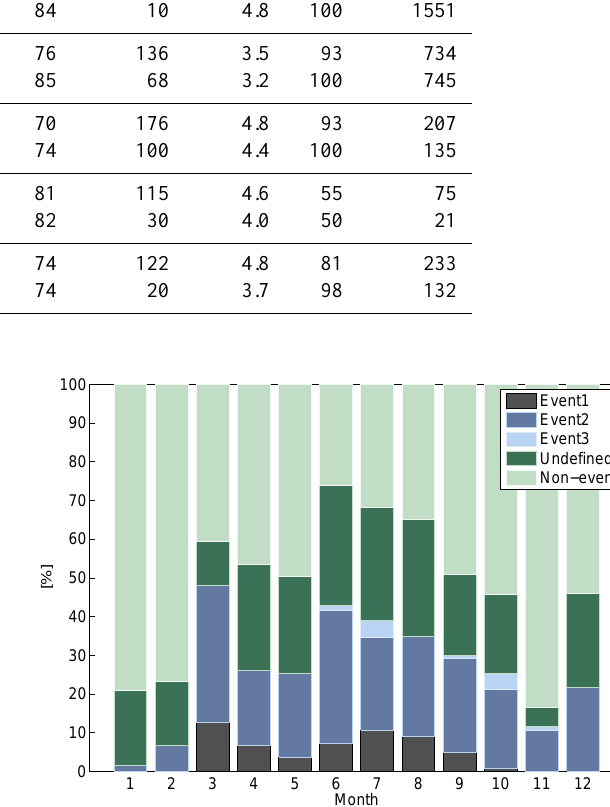
Figure 6. Classification of particle formation events into classes: 1 (strong event), 2 (weaker event but calculation of growth rate, GR, and formation rate, FR, possible), 3 (weak event, not possible to calculate GR and FR), undefined, and non-event day. Fractions of different types of events are shown for each month for the whole measurement period of about 4 years. More details on classification is found in Dal Maso et al.